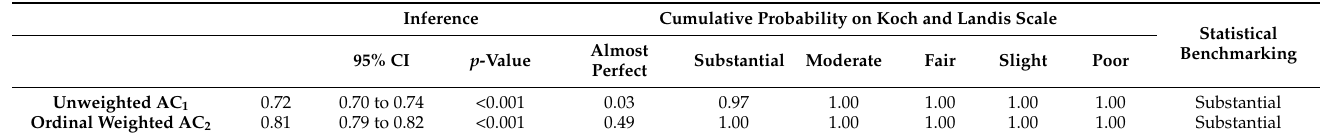
Table 5. Inferential statistics of agreement